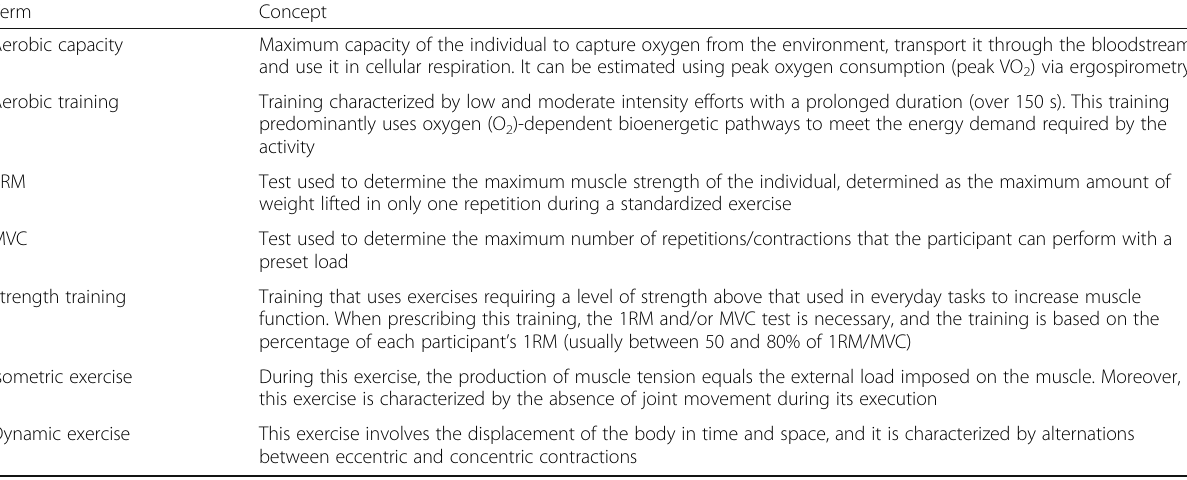
Table 1 Concepts used in physical training Term